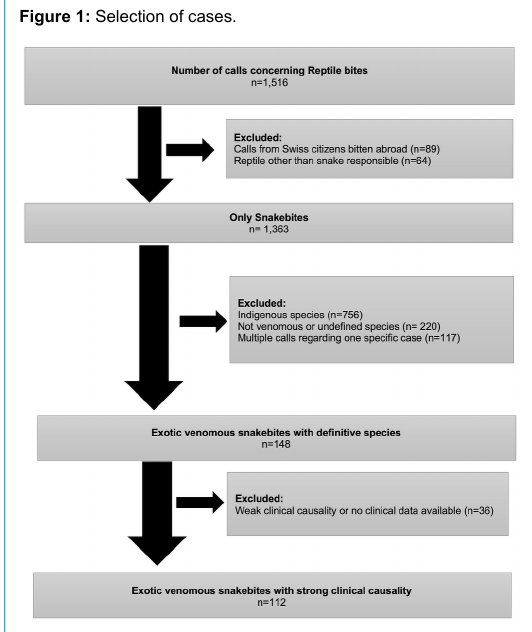
Figure 1: Selection of